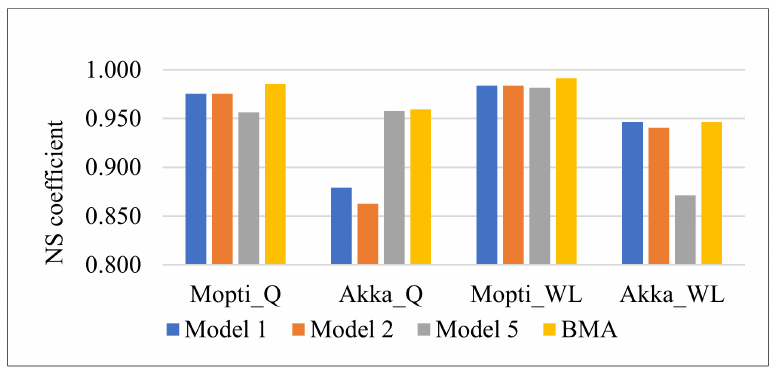
Figure 9. Comparison of the Nash-Sutcli ff e (NS) coe ffi cient of BMA and the three best individual